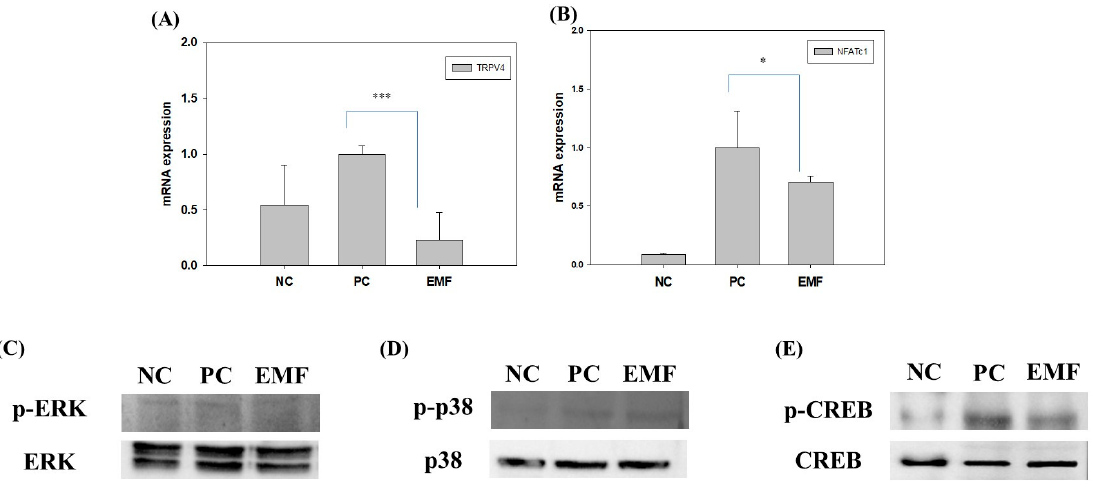
Figure 6. Regulation of the RANKL signaling pathway by EMF exposure. The mRNA levels of ( A ) TRPV4; and ( B ) NFATc1 and protein levels of ( C ) p-ERK, ( D ) p-p38, ( E ) p-CREB in Raw 264.7 cells differentiated for 4 days in differentiation media (with RANKL) with or without EMF exposure. NC, cells grown in growth media (undifferentiated); PC, cells grown in differentiation media (with RANKL); EMF, cells grown in differentiation media (with RANKL) with EMF exposure. The symbols * and *** indicate, respectively, significant differences with p < 0.05 and p < 0.005.